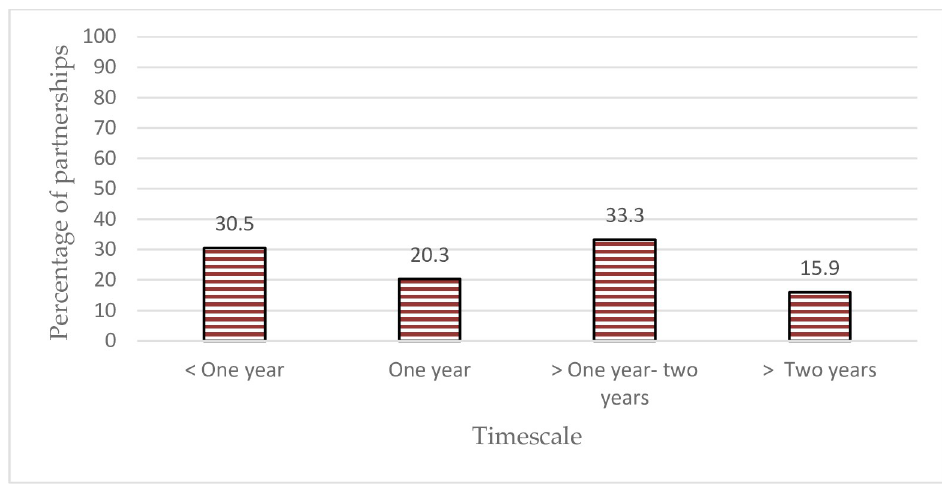
Fig 7 lists the duration of the partnerships. The results indicated that the timescale of the collaboration changed across the partnerships analyzed. About one third (33.3%) had the term ranging from a year to two years, followed by ones lasting less than a year (30.5%). 20.3% of partnerships lasted a year, while 15.9% persevered for more than two years. As to the geographical coverage of the partnerships shown in Fig 8, most (59.5%) cover gov- ernorate-level areas. Furthermore, 15.9%had activities performed at the national level. Other geographical coverage areas included the city (11.6%), the region level (10.1%), and a specific neighborhood (2.9%).